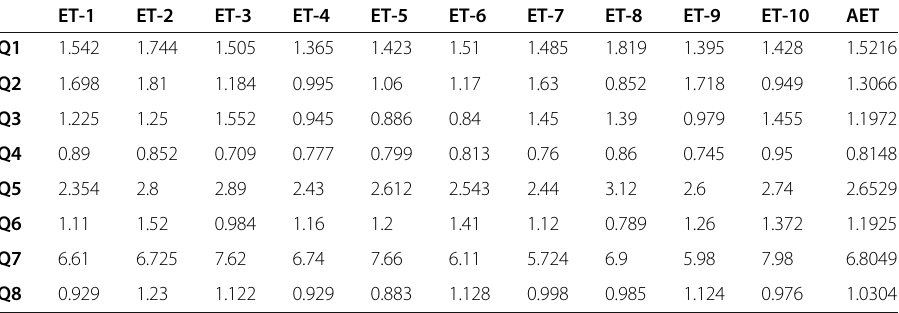
Table 4 Query execution time for Amazon EC2 with Colorado state data in HC-1